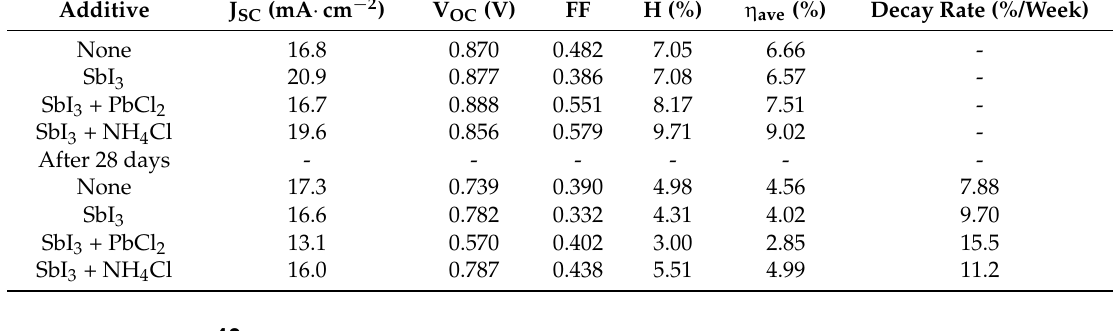
Table 2. Measured photovoltaic parameters (average and top) of TiO 2 /CH 3 NH 3 Pb(Sb)I 3 (Cl) cells.